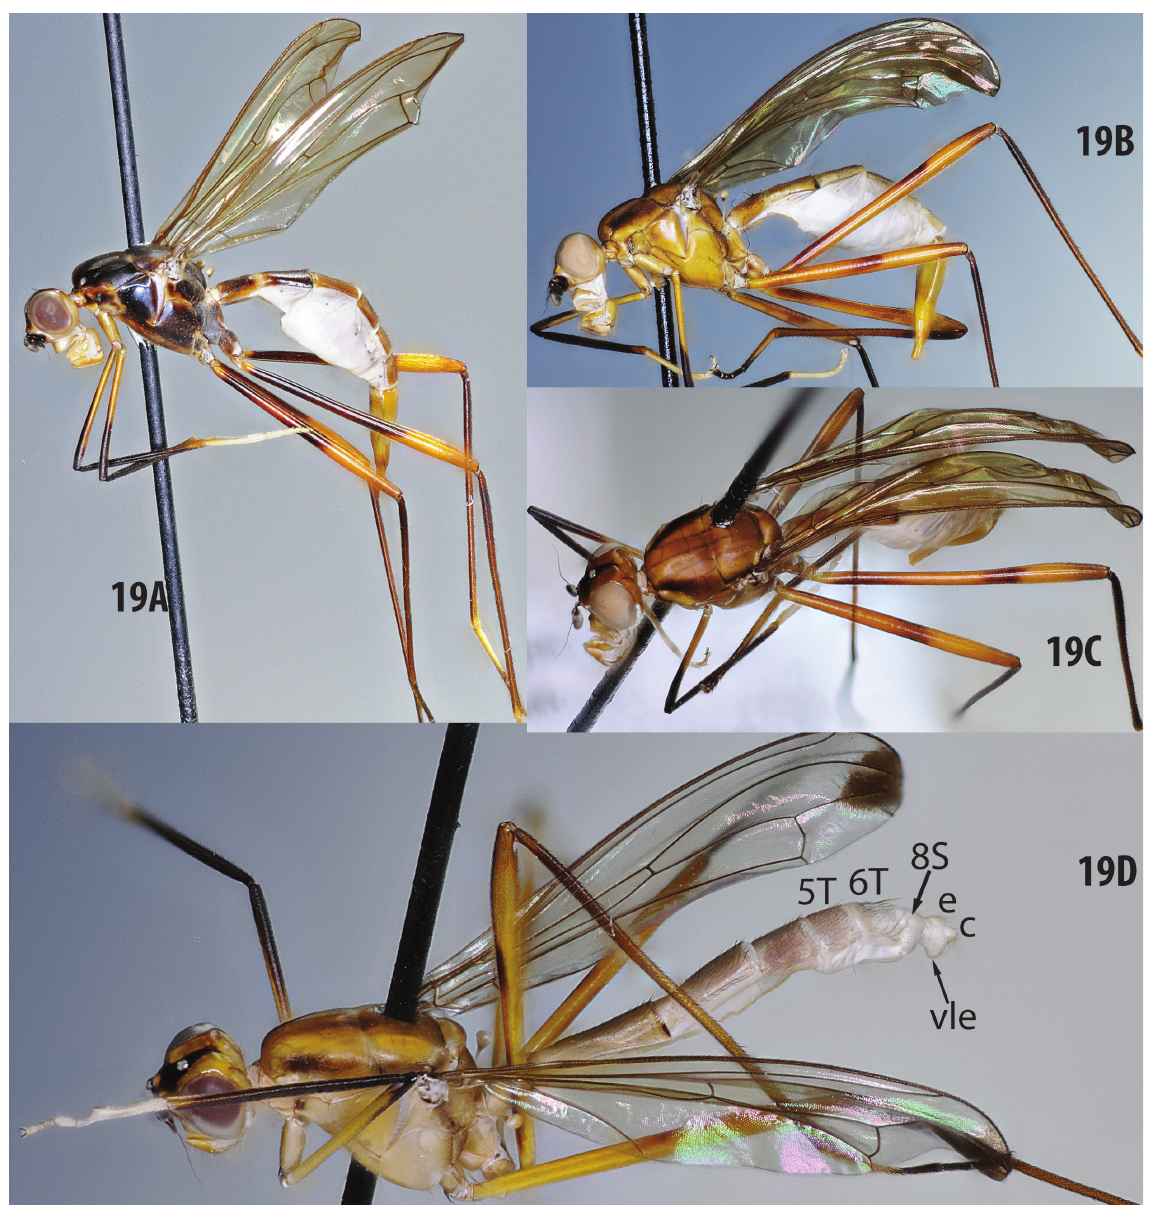
Fig. 19. Mesoconius suzukii sp. nov. A–C . ♀♀ (B and C are paratypes, IAVH). D . Holotype, ♂, IAVH. Abbreviations: c = cercus; e = epandrium; vle = ventral lobe of